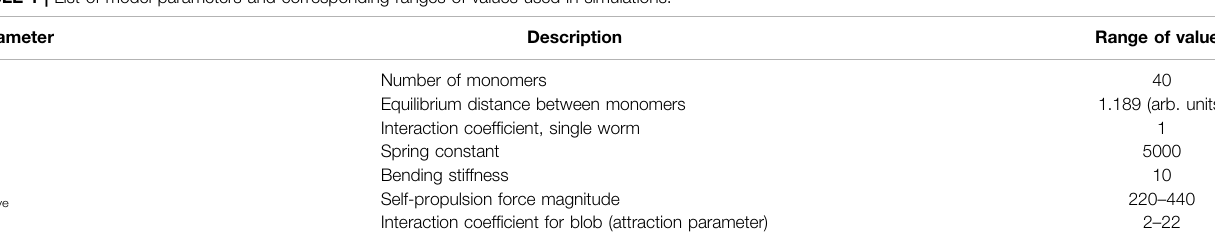
FIGURE 1 | Worm-inspired active polymer model. (A) . A single California blackworm ( L. variegatus ). (B) . An entangled worm blob consisting of 20 worms. (C) An entangled worm blob ( ∼ 20 worms) in a temperature gradient displays collective locomotion toward the cold side (right) , with “ puller ” worms extending from the front (wormheadsmarkedbyreddots). (D) .Polymermodelofsinglewormconsistingof40monomersconnectedbyspringswithinteractionpotentialdescribedin Eq.1 .The “ head ” section(withthedistalheadnodeindicatedbythereddot)ofthewormissubjecttoaconstant-magnitudetangentialforce (cid:2) F Thespringforce (cid:2) F spring ( Eq.2 )iscomputedforadjacentpairsofmonomers,andthebendingforce (cid:2) F bending ( Eq.3 )foradjacenttripletsofmonomers.Theinteractionforce (cid:2) F interaction ( Eq.1 ) iscomputed for everypair ofmonomers in achainand isattractive if themonomersarefurtherapart than theequilibrium distance are closer than σ . (E) . Simulated worm blob consisting of 20 polymers. Each color represents a different worm. The interaction force (cid:2) F interaction ( Eq. 6 ) is computed for every pair of monomers and is stronger between monomers of different chains. (F) . Simulated worm blob in atemperature gradient with the hotter side on the left (black background) and the colder side on the right (white background) demonstrates collective locomotion toward the cold side. Red dots indicate the head ends of each worm; some worm heads protrude from the bulk of the blob.